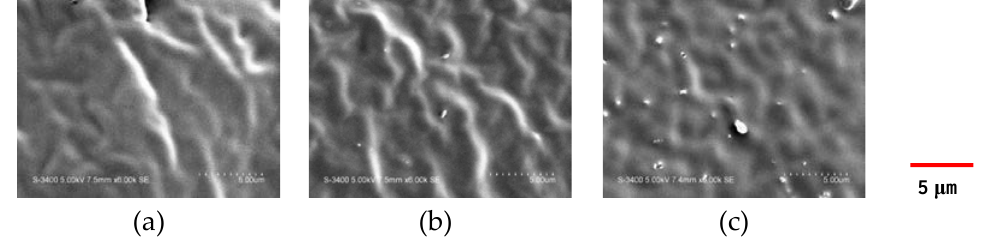
Figure 1. SEM cross-section images of PESu/h-BN composites with different compositions: ( a ) 100/0; ( b ) 99/1; and ( c )